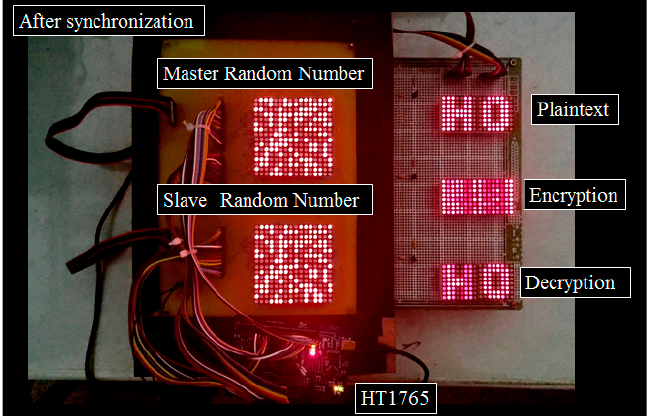
Figure 17. The secure communication system after synchronization.